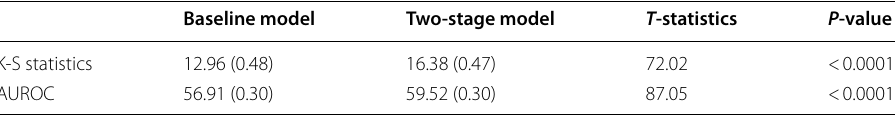
The numbers in parentheses represent standard